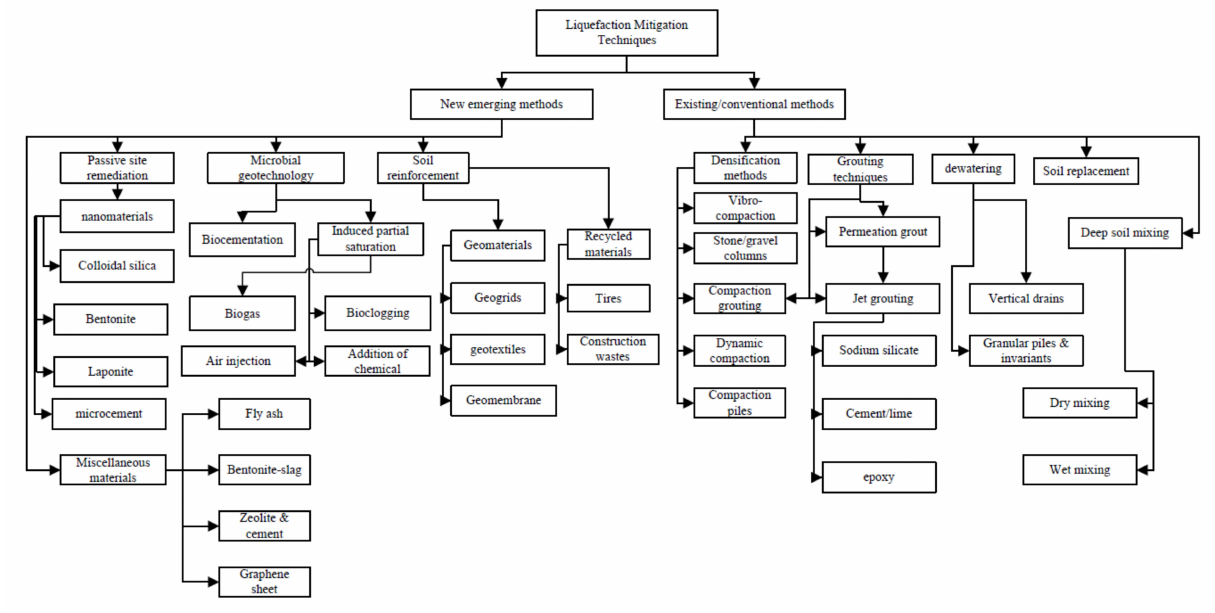
Figure 1. A summary of soil liquefaction mitigation